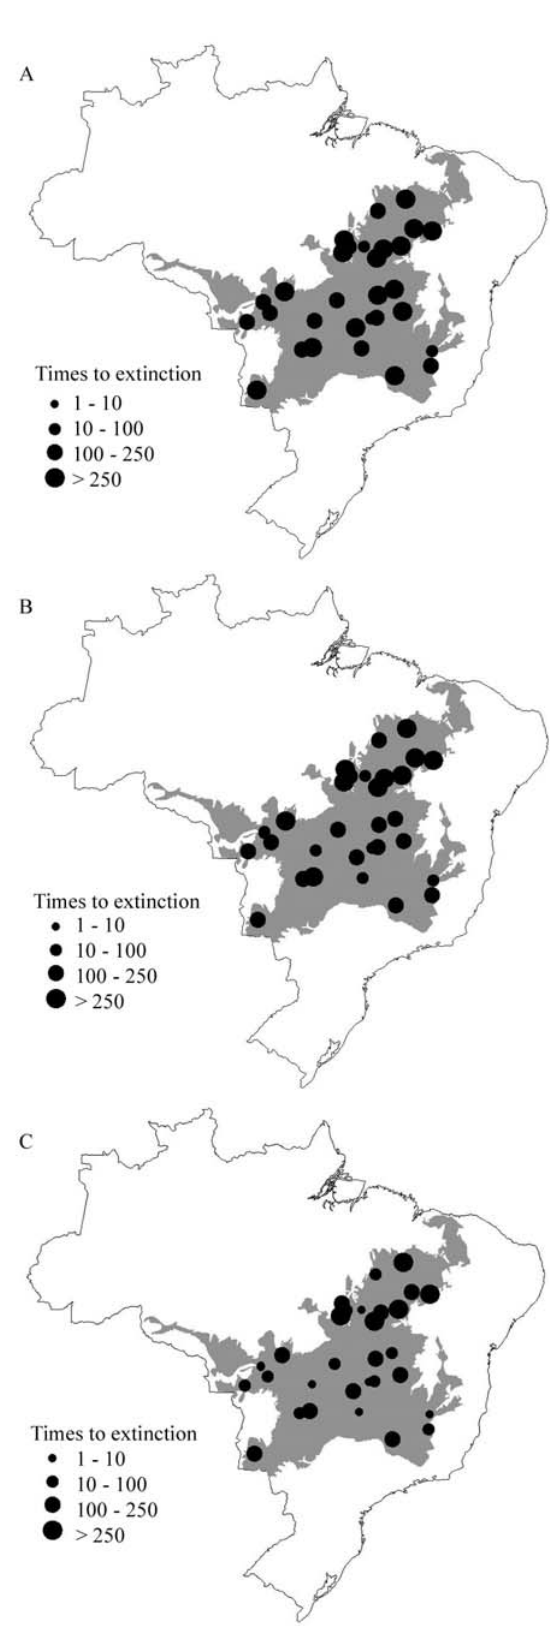
Figure 1 - Results of the simulations in 31 conservations units, showing the variation in times to extinction (years) for the different body-size classes: 500 g (A), 5000 g (B), and 50000 g